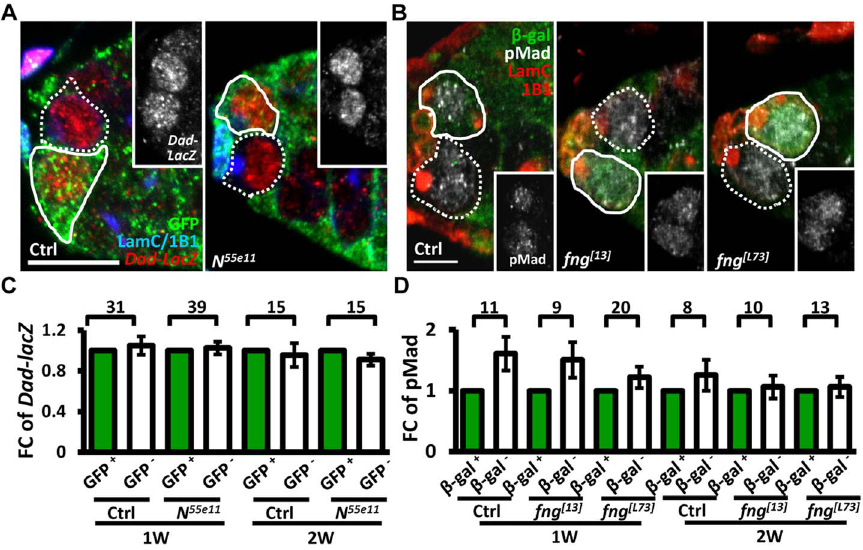
Fig. 2. Notch signaling-deficient and control GSCs exhibit comparable levels of BMP signaling. (A and B) One-week (w)-old mosaic germaria. Germaria with GFP (green, wt cells in A), ß-gal (green, wt cells in B), 1B1 (blue, GSC fusomes), LamC (blue, cap cell nuclear envelopes), Dad- lacZ (red, A), and phospho (p)-Mad (gray, B) labels. Wt GSCs are outlined by solid lines; control or mutant GSCs (GFP-negative ( 2 ) in A and ß-gal 2 in B) are outlined by dashed lines. Scale bar: 10 m m. (C and D) Average fold changes (FC) of Dad-LacZ (C) and pMad (D) intensity in GFP 2 and ß-gal 2 GSCs, respectively. Values were normalized to those of a wt GSC within the same niche. The number of germaria analyzed is shown above each bracket. The genotype of the control germaria is hs-flpneoFRT19A/ubiGFPFRT19A in A and C, and hs-flp/ + ; neoFRT80B/arm-lacZFRT80B in B and D.